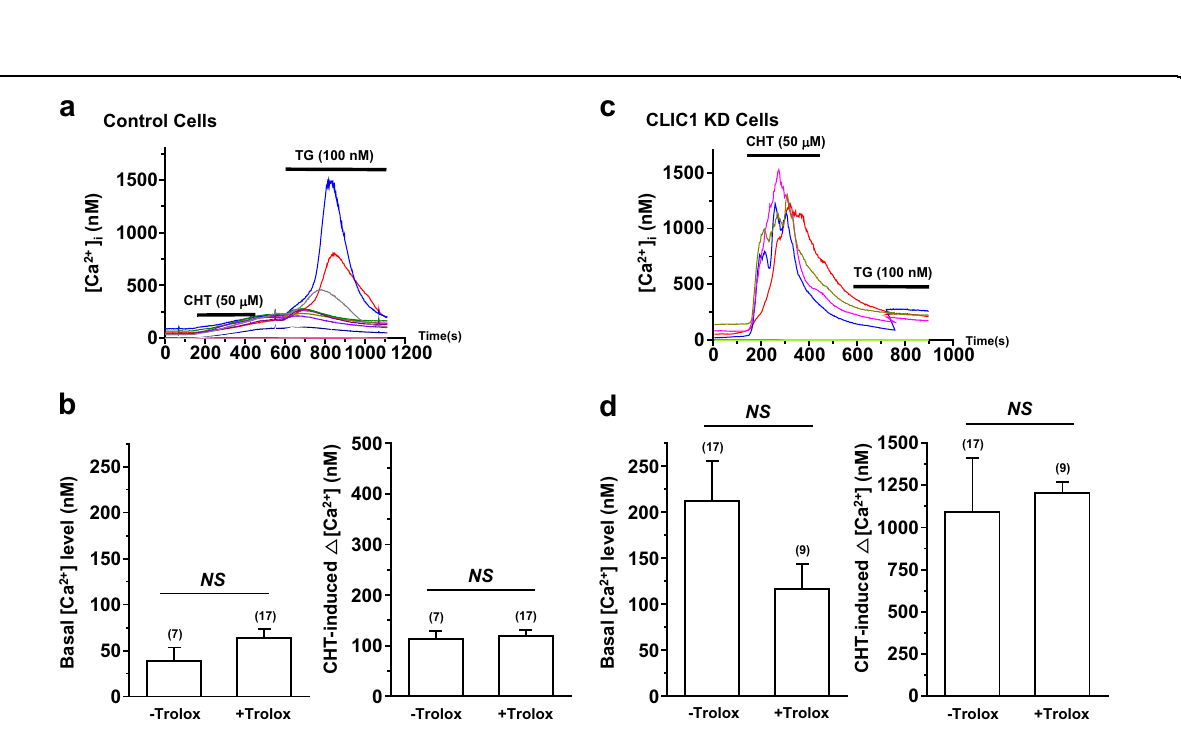
Fig. 5 The increase in the Ca2 + level in CLIC1-knockdown cells is not prevented by Trolox. a, c Time-dependent measurement of [Ca 2 + ] i in the presence of chelerythrine chloride (CHT, 50 μ M) in control cells ( a ) and CLIC1 KD cells ( c ) after pretreatment with Trolox (10 μ M, 24 h). b, d Quanti fi cation of the basal [Ca 2 + ] i and chelerythrine-induced Δ [Ca 2 + ] i in control ( b ) and CLIC1 KD A549 cells ( d ) as shown in ( a ) and ( c ), respectively. P -values were determined by Student ’ s t -test, and the values shown are the means ± SEMs. NS , not signi fi cantly